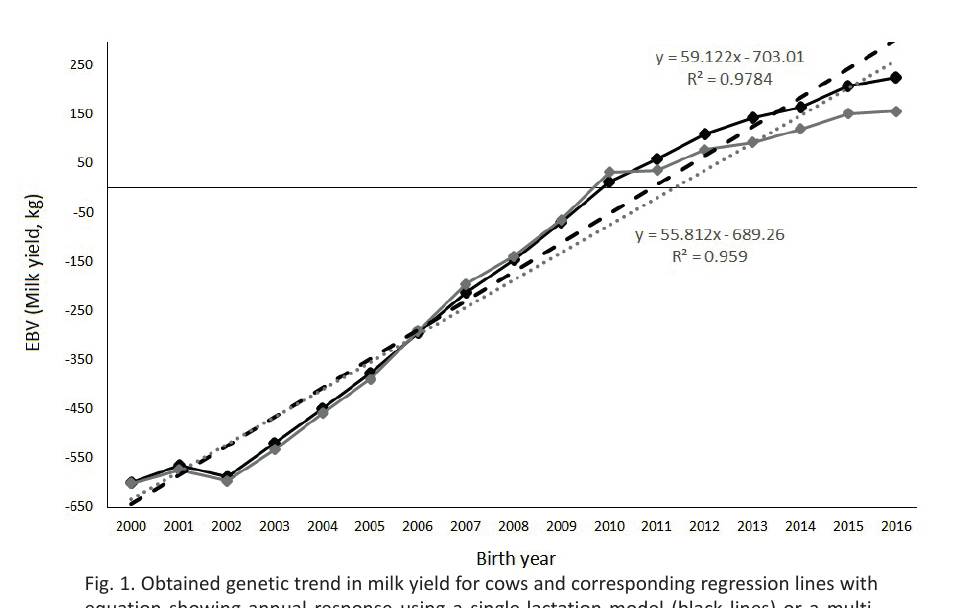
1. Obtained genetic trend in milk yield for cows and corresponding regression lines with equation showing annual response using a single-lactation model (black lines) or a multi- lactation model (gray